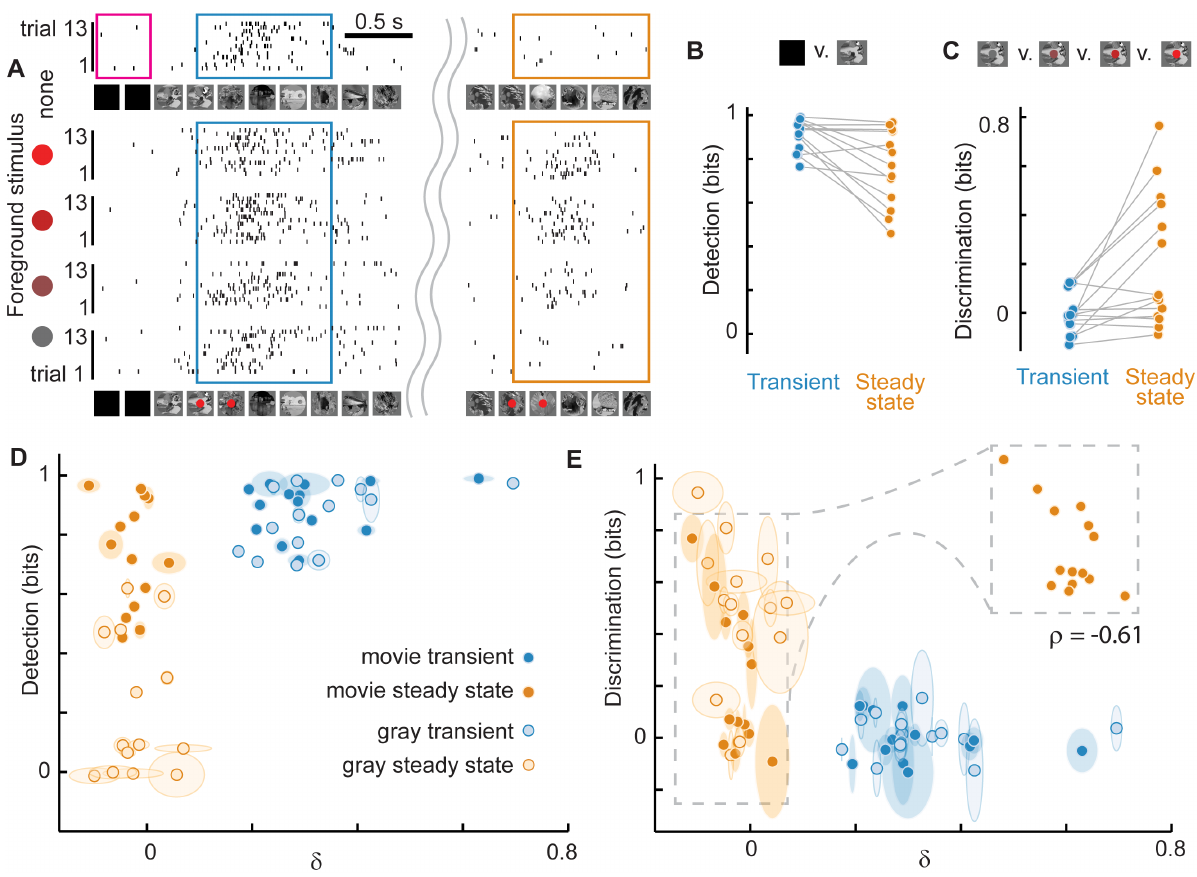
Fig 3. Adaptation enhances discrimination at the cost of reduced detection: LFP rate coding. ( A ) TOP: Typical rasters of LFP peaks (taken from all electrodes, randomlysubsampledto 10%) showingresponseto 13 trials with the same background movie visual stimulus (no foreground). Detection was quantified based on the LFP peak count when the movie was off (pink box) comparedto when the movie was on (blue or orangebox). BOTTOM: For discrimination a foregroundstimulus (4 different red dots) was presentedduringeach of four blocks with 13 trials each, all with the same background movie stimulus. The red dot was presentedeither duringthe transient periodjust after background stimulus onset (blue box) or later duringthe steady-state (orangebox). Note that the different foregroundstimuli were more easily distinguished by the LFP peaks in the steady-state comparedwith the transient, but the presenceof the background stimulus is more easily detected based on strong transient response. ( B ) Summary (n = 14 turtles) of how well the LFP peak count can detect the presenceof the background stimulus. All turtles show a decrease in detectionfrom transient to steady-state. ( C ) Summary of how well the LFP peak count can discriminate the four different foregroundstimuli. Most turtles showedan increasein discrimination from transient to steady-state. ( D, E ) A more refined explanation of detectionand discrimination is obtained by comparing to δ . Generally,lower δ resulted in enhanced discrimination and poorer detection, while higher δ exhibitedthe opposite trend. Thus, power-law distributed (low δ ) population dynamicsare associatedwith a functionaltrade-off, gainingdiscrimination at the cost of decreased detection. The inset is an expanded view to better show the correlationbetweendiscrimination and δ duringthe steady-state.